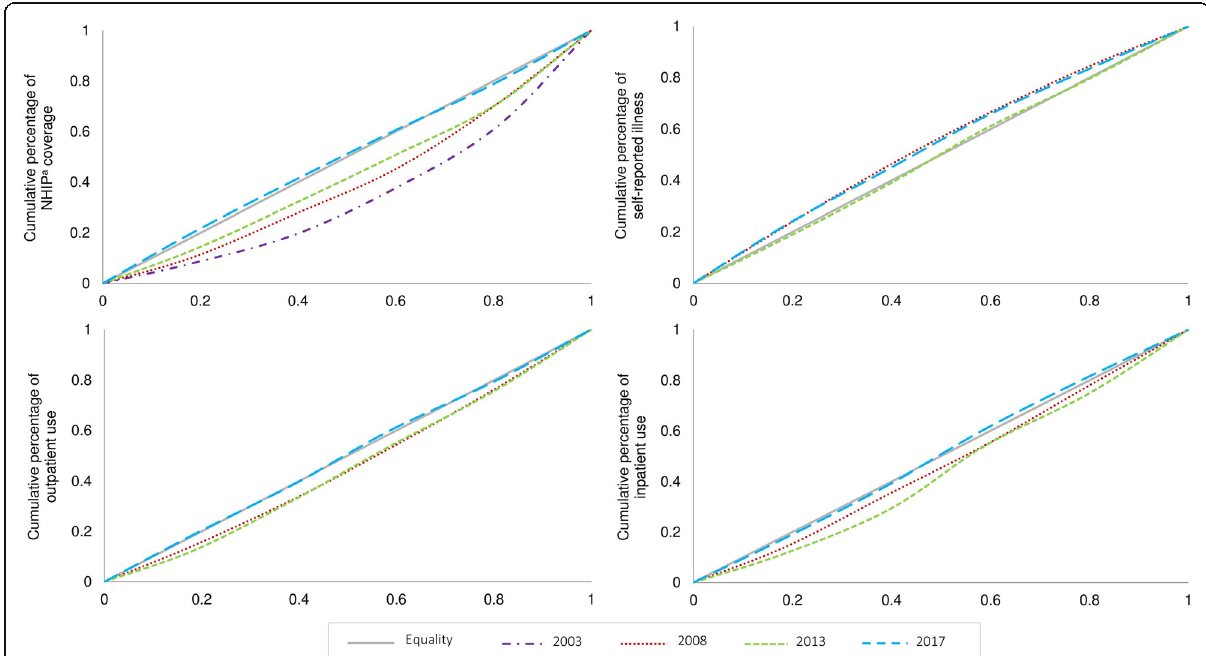
Fig. 1 Concentration curves for NHIP a coverage, self-reported illness, and healthcare utilization b according to wealth index (2003-2017). a